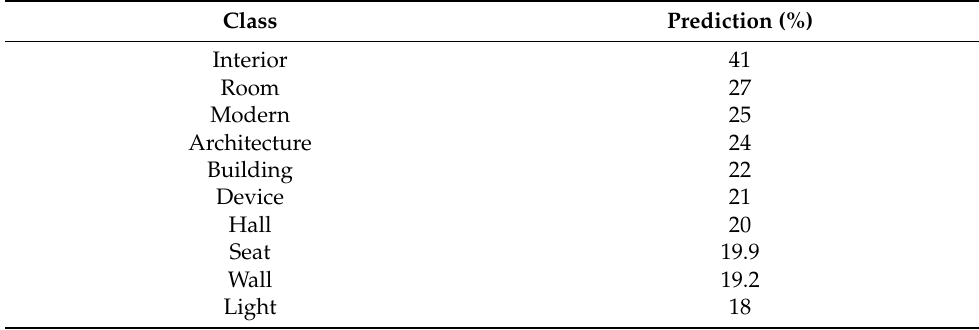
Table 4. Prediction results of the panoramic image generated by Tabkha’s approach.